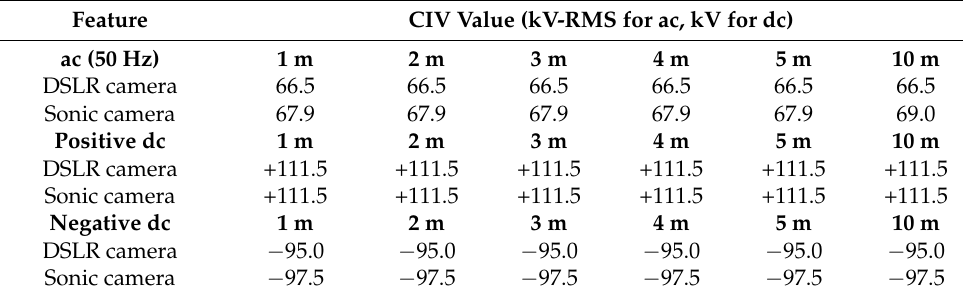
Table 5. CIV values that were obtained with the substation